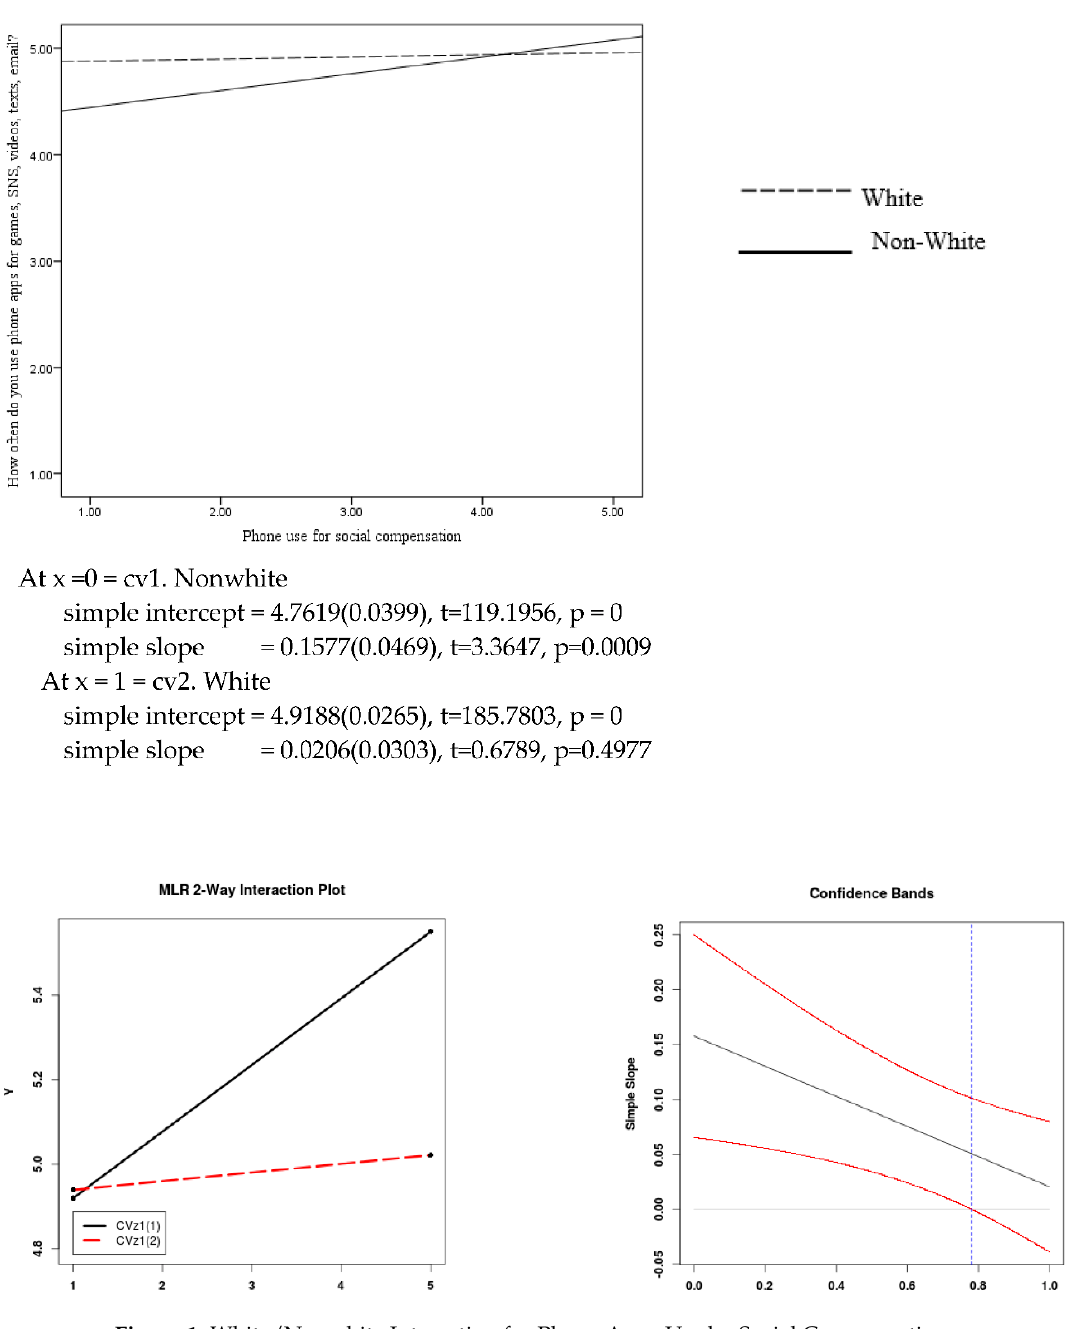
Figure 1. White/Nonwhite Interaction for Phone Apps Use by Social Compensation.